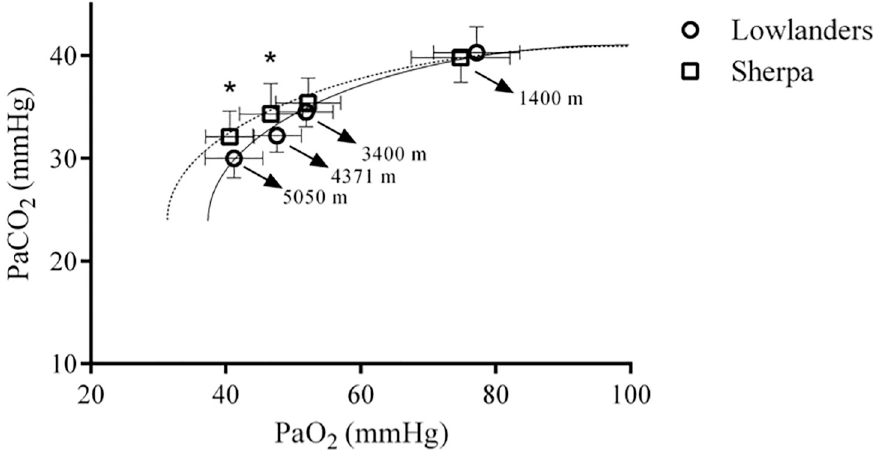
Fig 4. Rahn & Otis curves for Sherpa and lowlander upon ascent to altitude. Lowlanders are denoted by the open circle symbol ( � ), and Sherpa by the open square symbol ( □ ). Moving right to left, data are plotted from